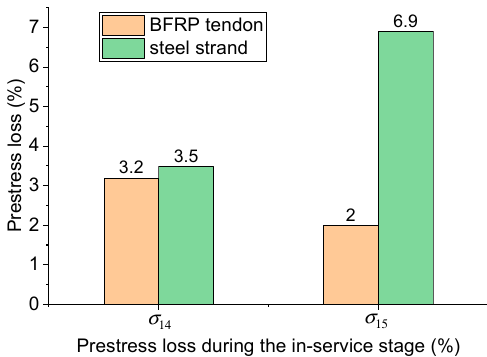
Figure 2. Comparison of prestress loss of BFRP tendons and steel strands during the in-service stage at various slab widths and distribution angles (%).